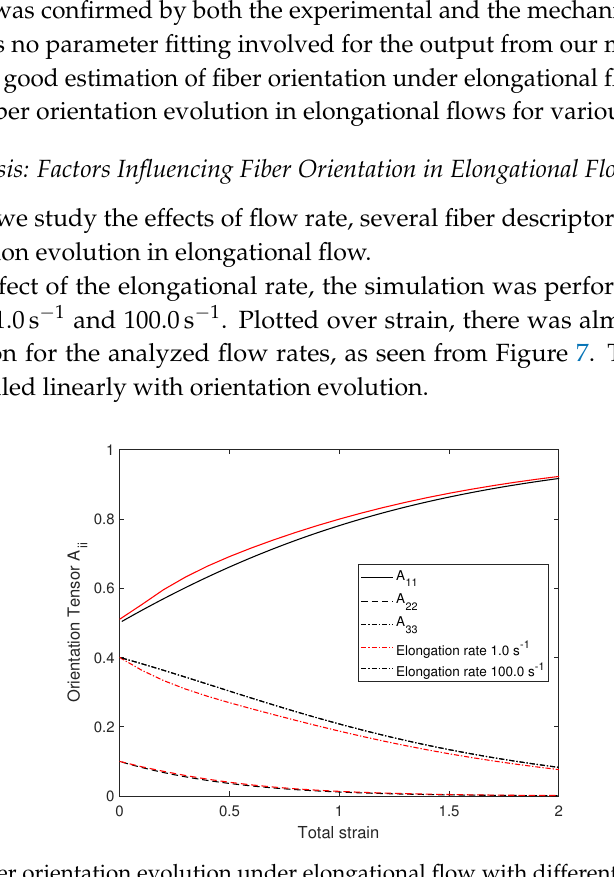
Figure 7. Fiber orientation evolution under elongational flow with different elongation